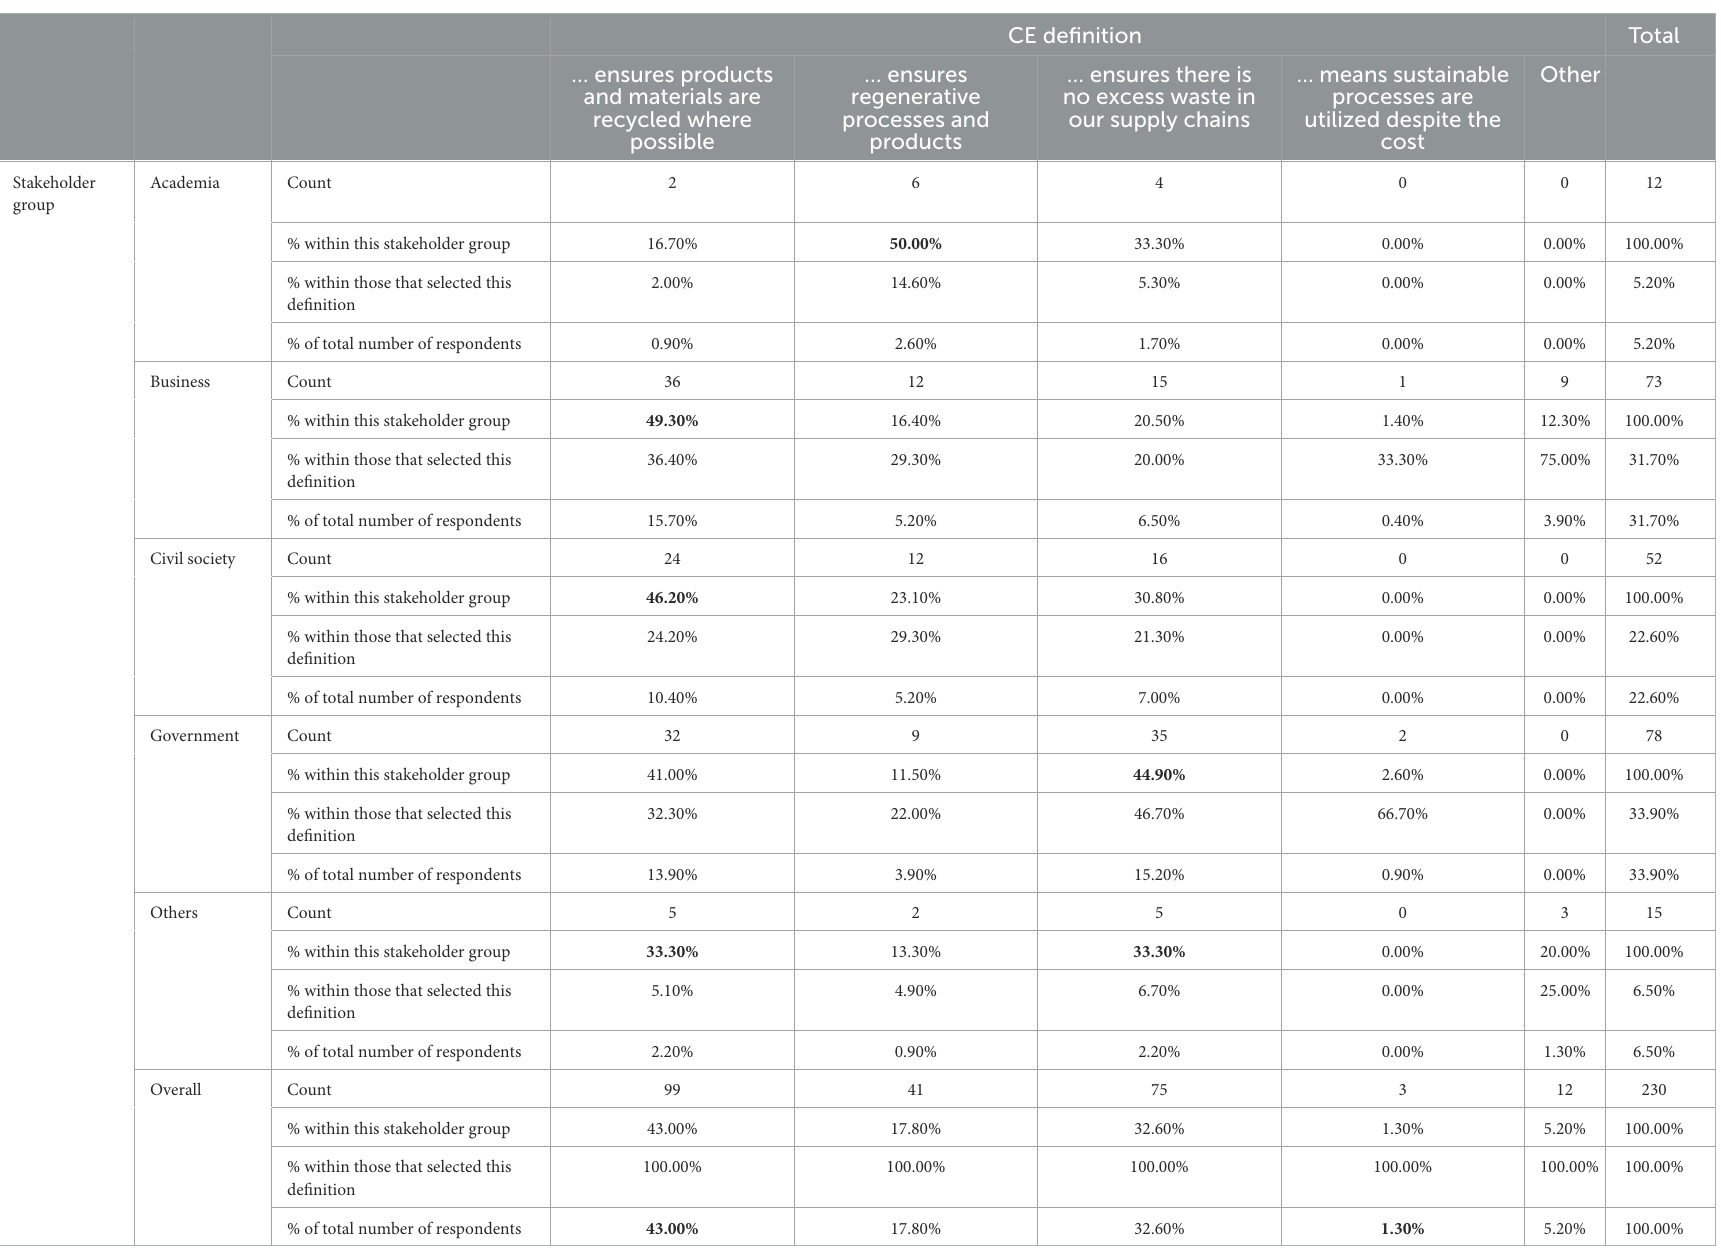
TABLE 1 Variations in CE definition with stakeholder